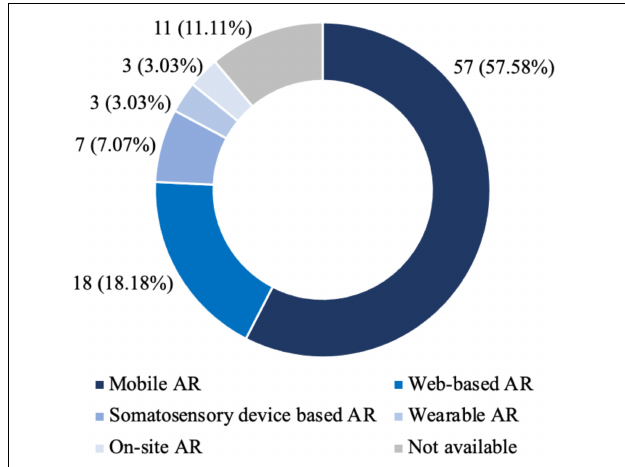
FIGURE 6 | Augmented reality